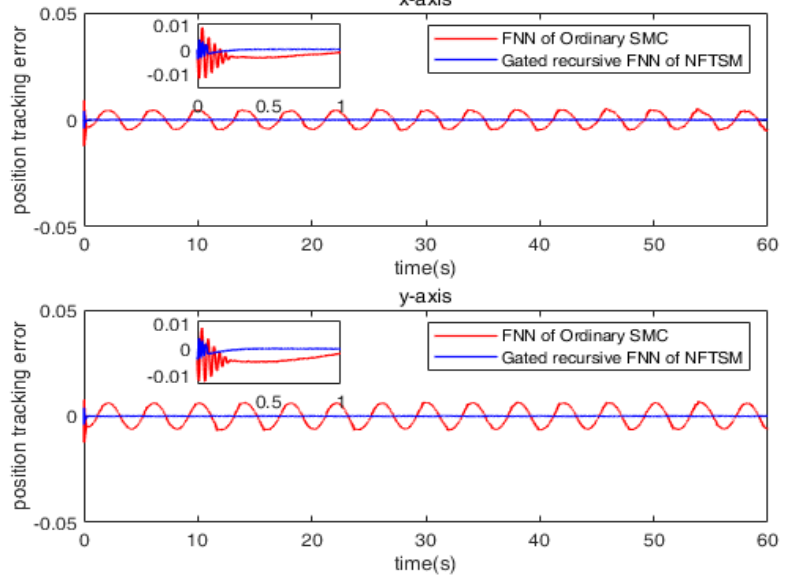
Figure 12. Comparison of the position tracking error between NFTSMC ‐ GRFNN and SMC ‐ FNN.